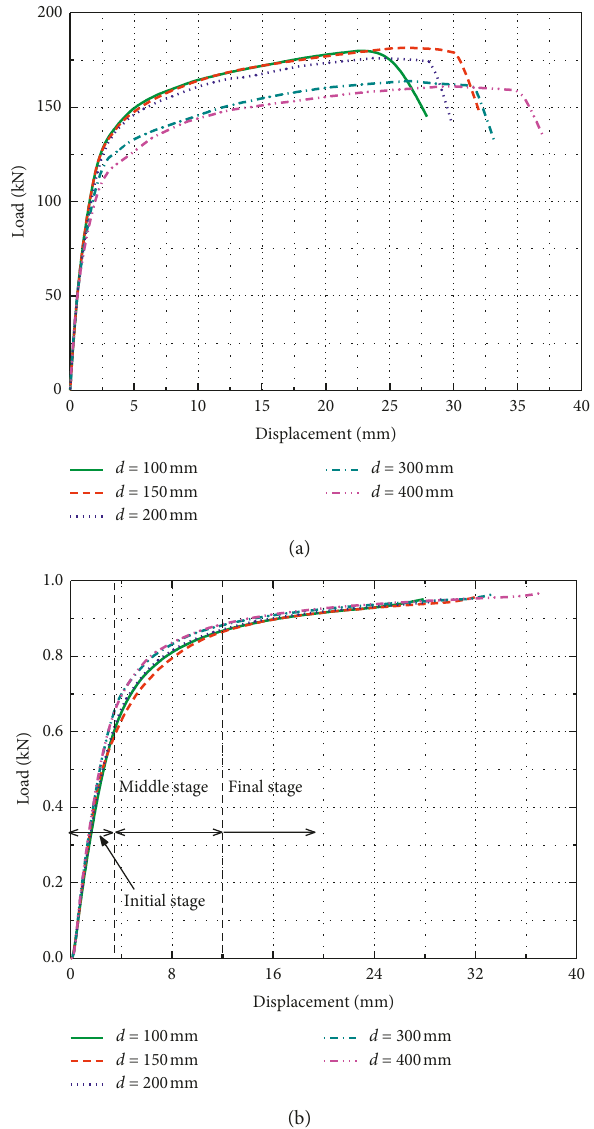
Figure 27: Result comparison of the models with various d : (a) backbone curves and (b) damage